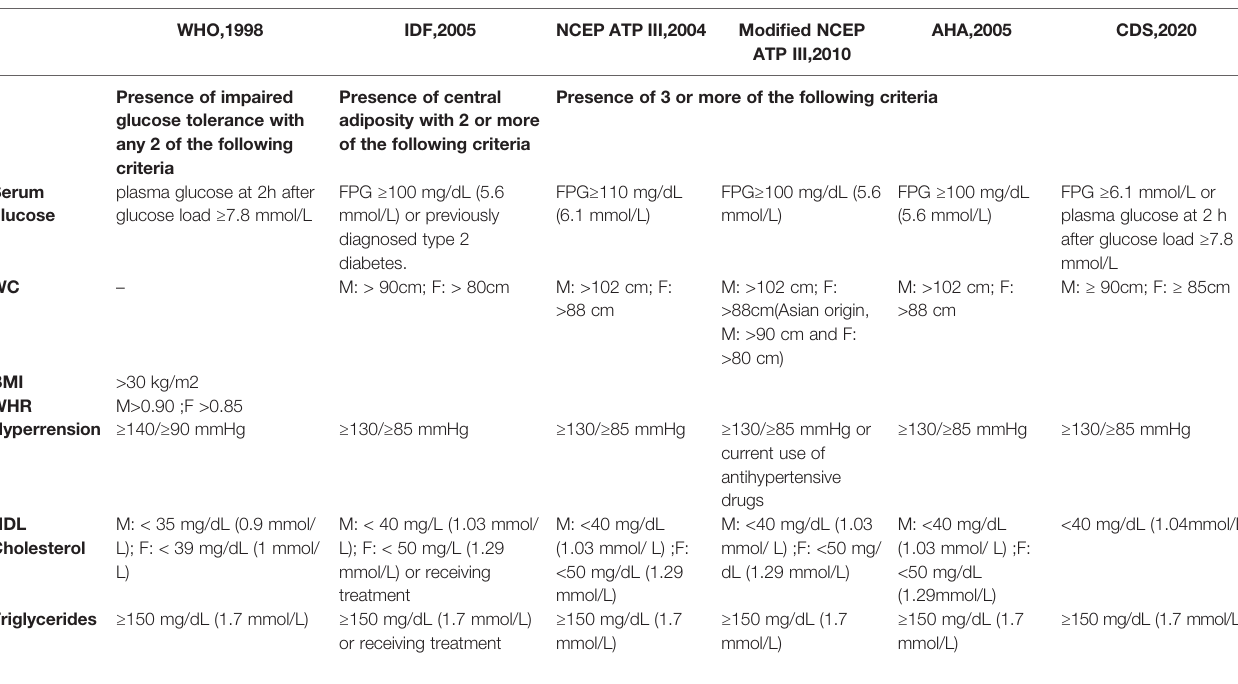
TABLE 1 | Criteria for diagnosing